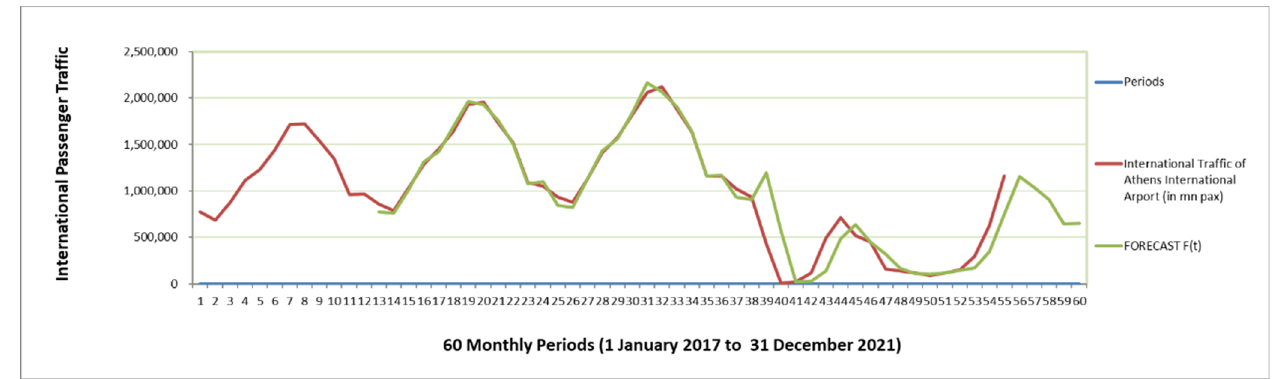
Figure 7. Model fitting and forecast for international pax traffic in AIA.